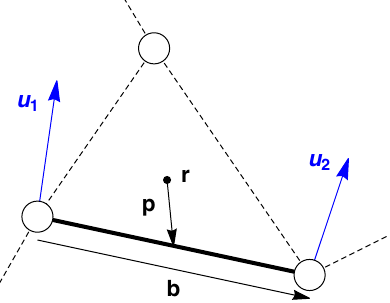
FIG. 1. A periodic spring network has a periodic microstructure consisting of bonds connecting sites, as in the generalized kagome lattice shown here. A solid bond is located at p relative to the center r of the cell in which it lies. The bond connects two sites with relative position b , undergoing displacements u 1 ð r Þ ; u 2 ð r Þ that cause extension or compression of the bond. For continuum fields, the displacements may differ greatly for each site within the repeating cell but vary smoothly across the